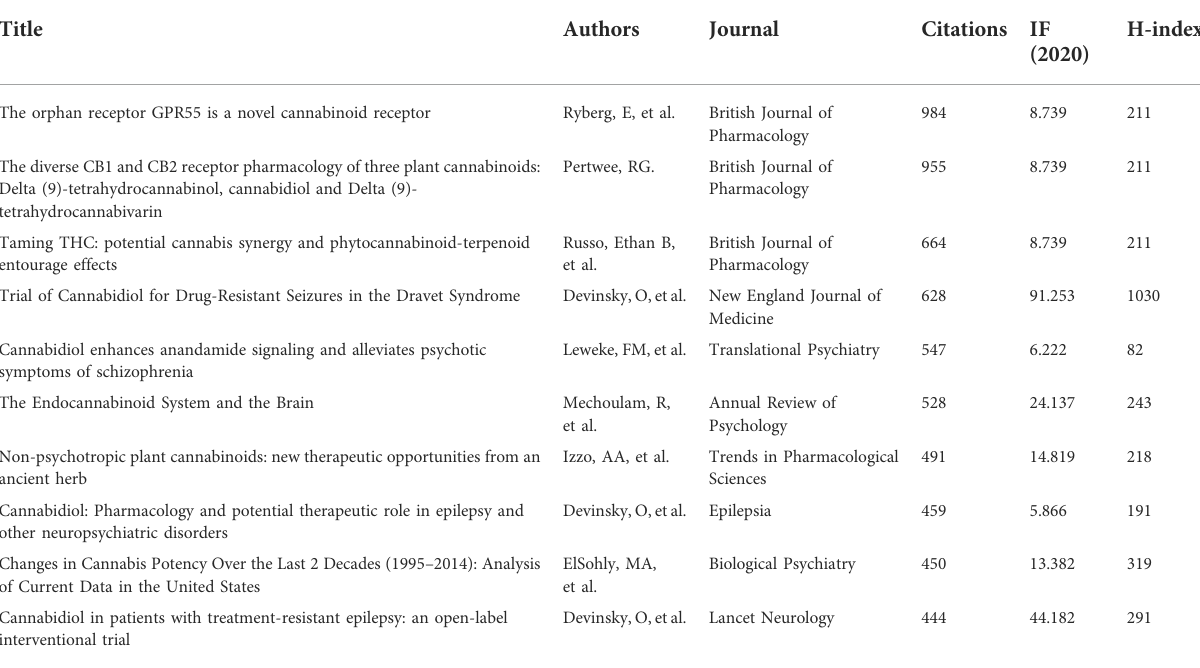
TABLE 4 The top 10 most cited articles from 2004 to